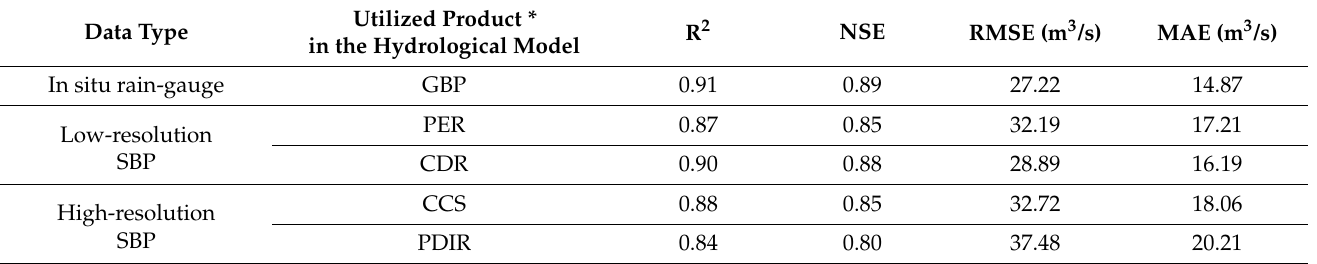
Table 5. The summary of the performances of HVEs (the calibration period, 2003–2008 WY period).